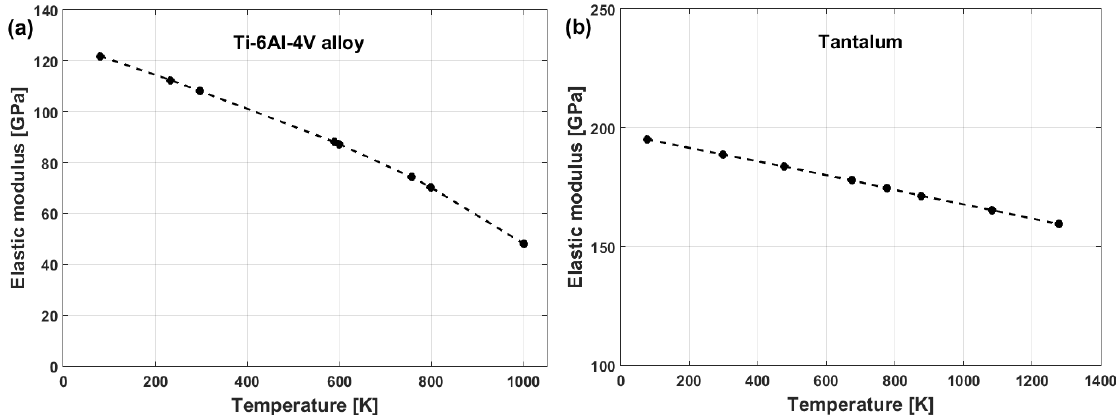
Figure 49. Elastic modulus vs. temperature for ( a ) Ti – 6Al – 4V alloy and ( b ) tantalum.